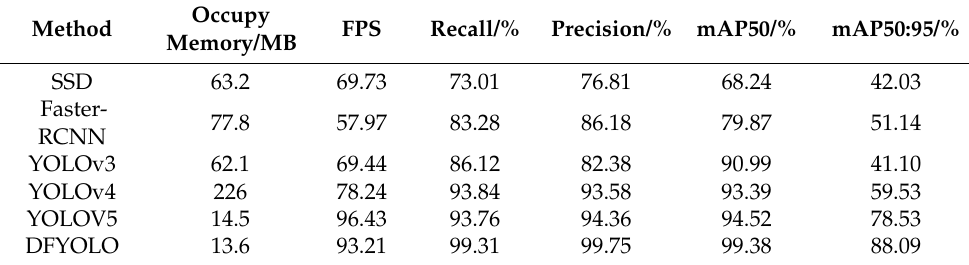
Table 4. The detection results of different detection